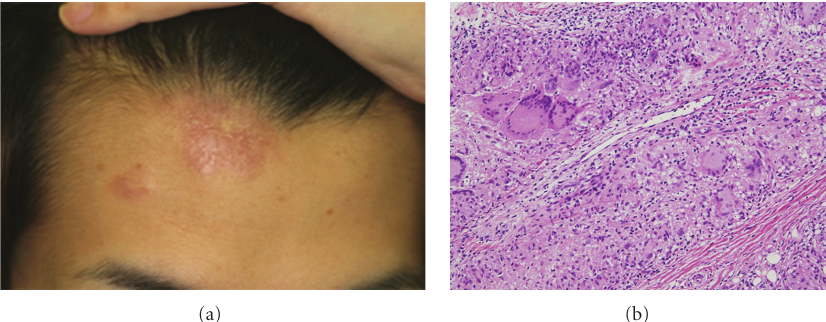
Figure 1: Photograph of the skin of the forehead (a) and pathological finding of the skin biopsy (b). Noncaseating granuloma composed of epithelioid cells and multinucleated giant cells were present.